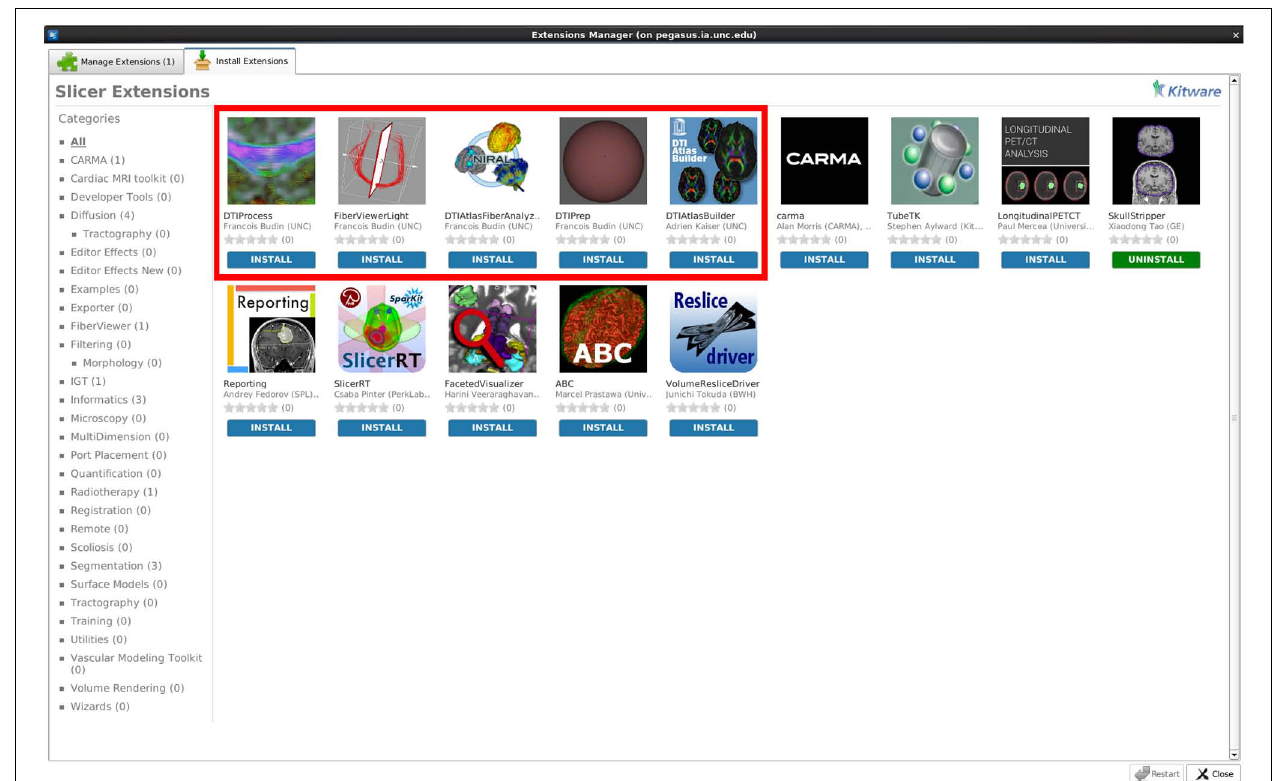
FIGURE 9 |A screenshot displaying our tools as available extensions in 3D Slicer (box highlighted to indicate our Slicer modules).